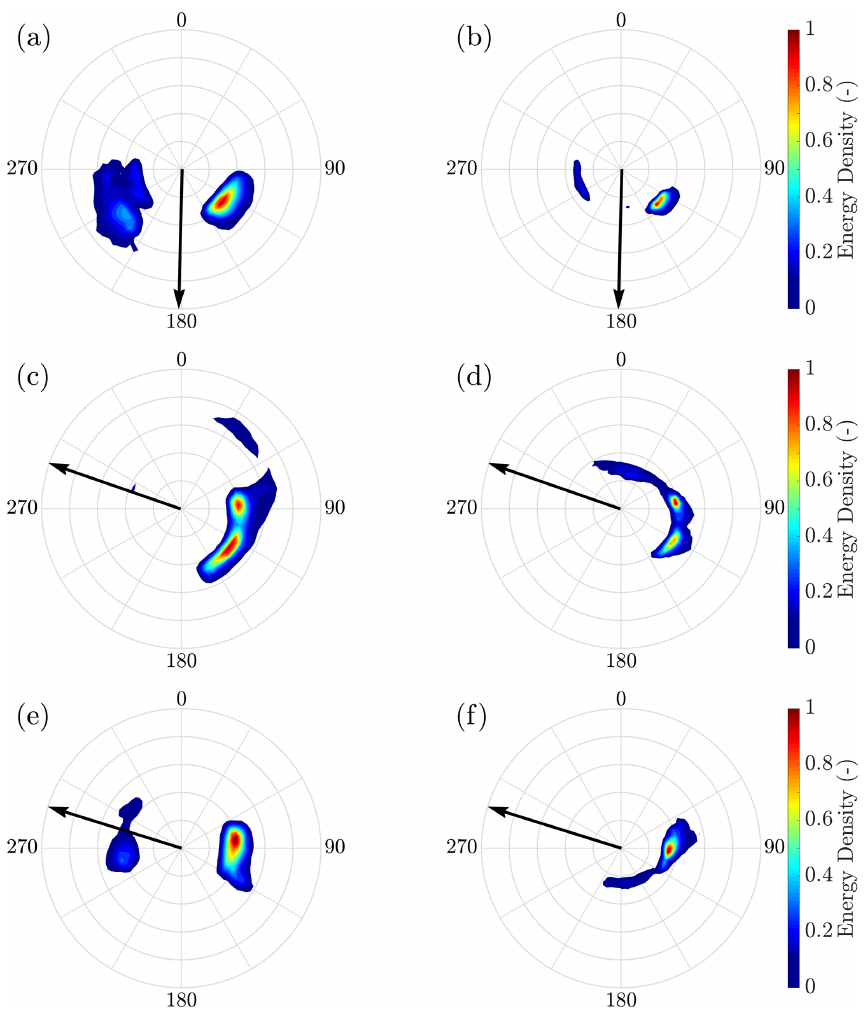
Figure 9. Example directional wave energy spectra recorded during ACE (a, c, e) and collocated SAR spectra (b, d, f) . Wind direction recorded during ACE is shown as black arrows. Both the wave spectra and wind direction follow the “coming from” convention. Circles in the polar plot indicate frequencies from 0.05Hz (innermost) to 0.25Hz (outermost) with a step of 0.05Hz; radiant lines indicate direction with a 30 ◦ step.